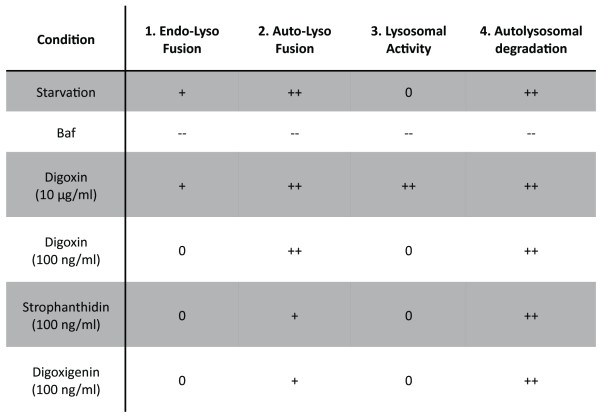
Drug profiling by multiparametric quantitative analysis of autolysosomal degradation pathways. Figure shows parameters for autolysosomal degradation pathways obtained by flow cytometry based screening of green fluorescent protein (GFP)-Rab7, GFP/mCherry (of mCherry-GFP (tandem)-microtubule-associated protein 1 light chain 3 B (LC3)) and LysoTracker Red (LTR).